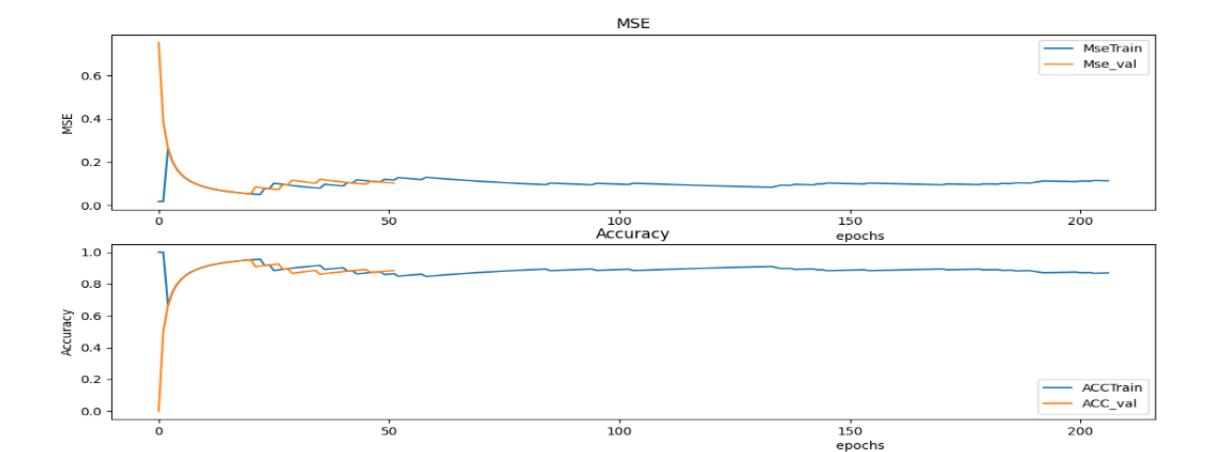
Figure 1 . Machine learning algorithm shows increased accuracy and decreased MSE values over the first 50 training rounds (ie, epochs) for predicting PQOL based on PSS (Accuracy: 0.88, MSE: 0.1)